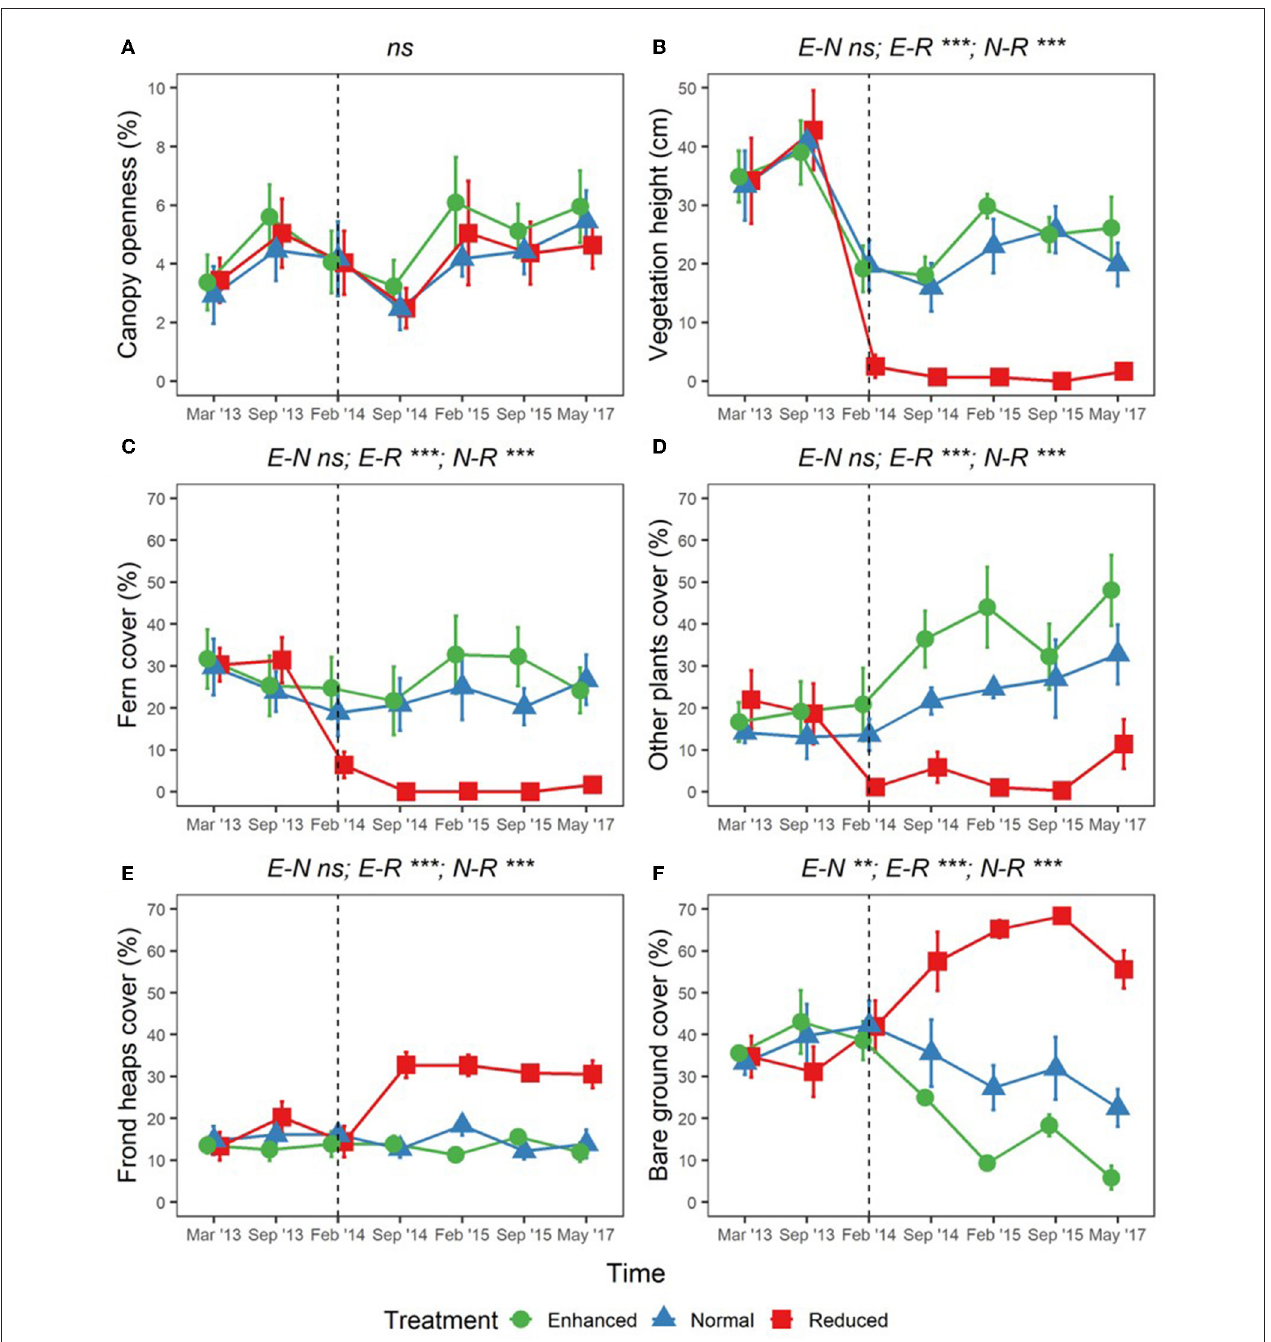
FIGURE 7 | Changes in percentage canopy openness (A) ; vegetation height (B) ; percentage cover of ferns (C) ; percentage cover of other plants (D) ; percentage cover of frond heaps (E) ; and percentage cover of bare ground (F) , across BEFTA Understory Vegetation Project plots 2013–2017 (“point vegetation data”). Data are split by plot treatment type (Enhanced, Normal, and Reduced) with the legend applicable to all six panels. Points represent the mean ( ± 1SE) across six replicate plots (except February 2015 where n = 5 owing to missing data), where each plot value is the mean of three 5 × 5m quadrats within it. The vertical dotted lines indicate the beginning of treatments. Before this point (March 2013, September 2013) all plots received the “business-as-usual” Normal understory management. From February 2014 onwards plots received different understory management according to their treatment designation (Enhanced, Normal, or Reduced). The surveys in February 2014 were conducted post-treatment. Asterisks and letters above each graph denote significance of differences between treatments [in the case of a single result, LLRT comparison results showing overall effect of Treatment:PrePost; and in the case of three results, where the significant differences lie after an overall significant result (results of lsmeans test), Supplementary Table 4 ]: *** p < 0.001, ** p < 0.01, ns, not significant. Points have been jittered around each time point to avoid overlap and therefore aid viewing.